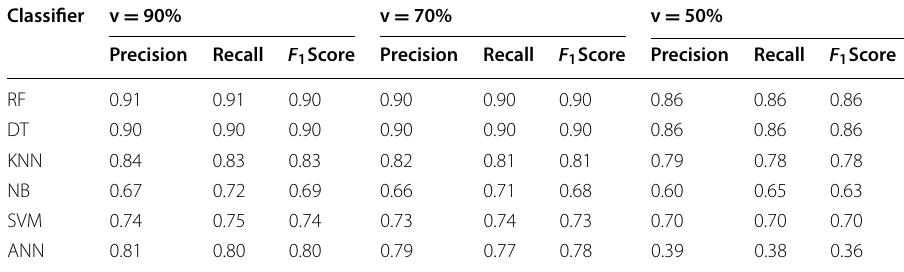
Table 2 Prediction results considering different variance utilizing the dataset of user U1 Classifier v 90% =